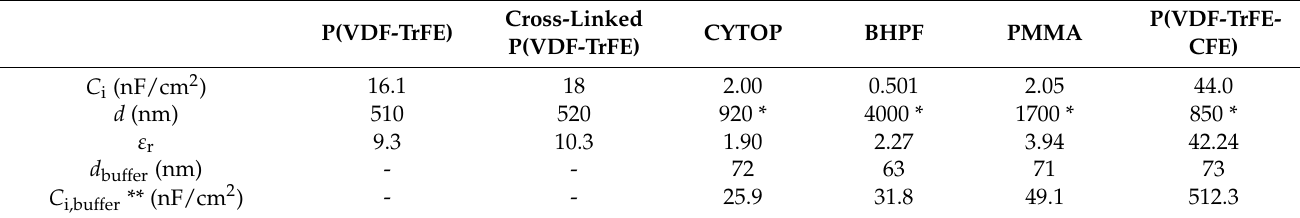
* The layer is intentionally thickly formed in order to reduce the leakage current for the exact measurement. ** The values are calculated using C i,buffer = C i × d d buffer